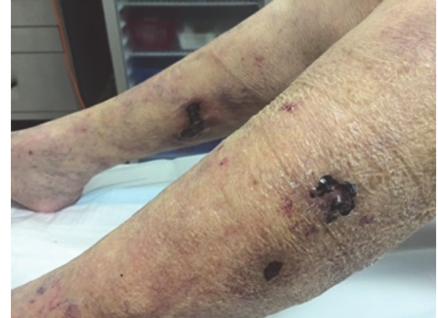
Figure 1: Necrotic ulceration on lower legs.